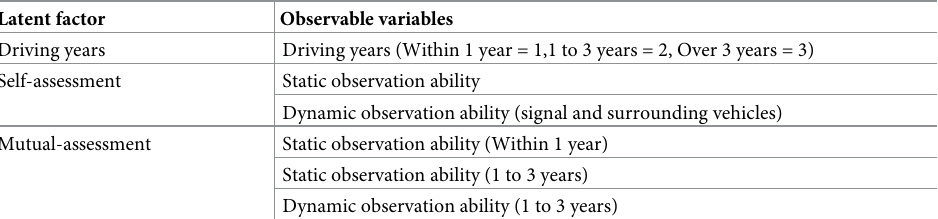
Table 6. Definition of variables in SEM.